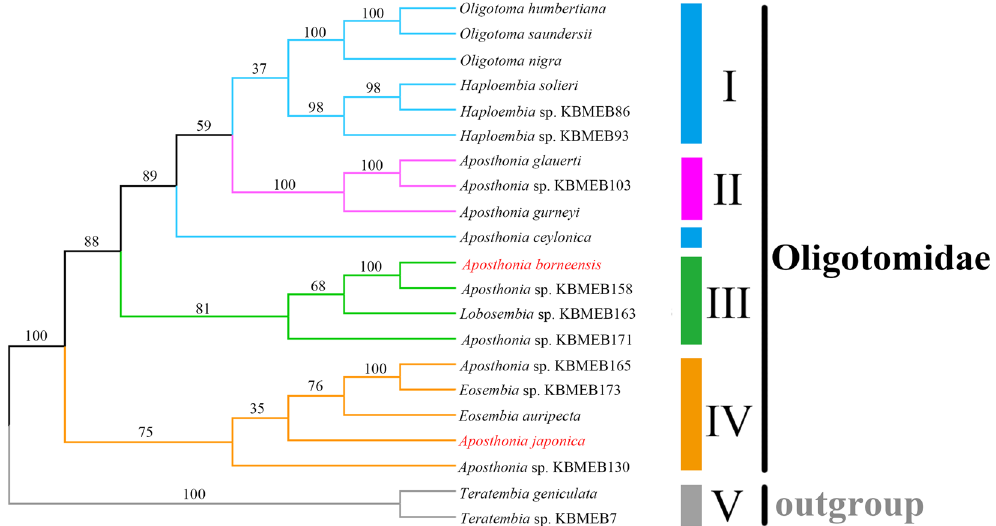
Figure 8. Maximum likelihood (ML) tree of Oligotomidae. Numbers on branches indicate bootstrap values. The tree was rooted with two outgroups, T. geniculata and Teratembia sp.